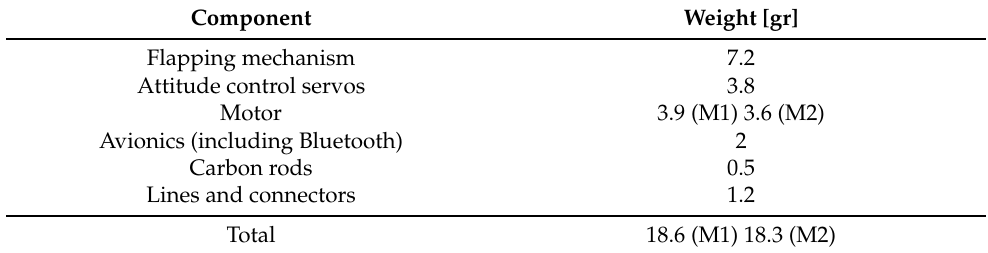
Table 1. Weight breakdown excluding the battery. The motors M1 and M2 refer to Table